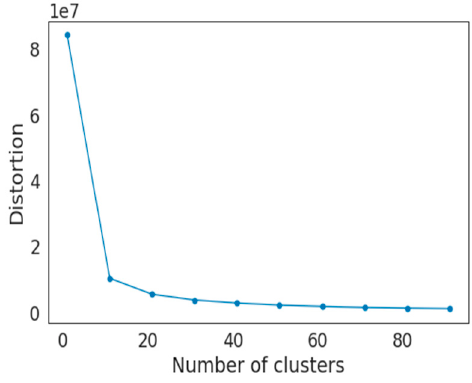
Figure 5. Elbow analysis.